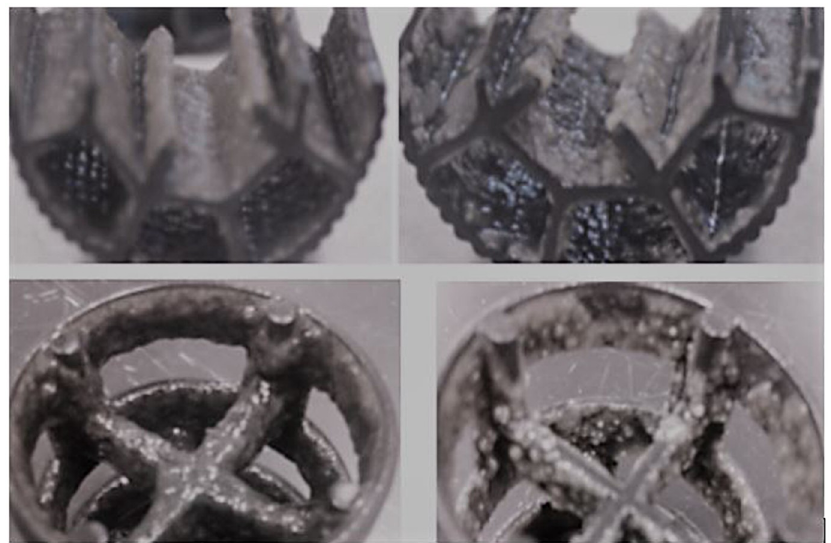
Fig 2. Plastic carrier media of LS IF SBR (upper row) and FS IFAS (lower row) systems with intact (left column) and sloughed biofilms (right